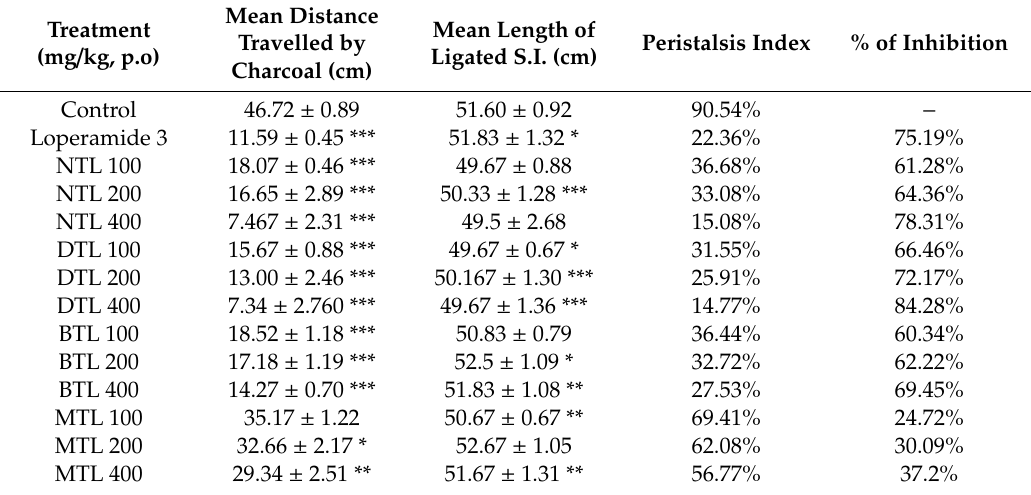
Table 4. E ff ect of methanol extract of T. leucostaphylum leaves and its derived fractions on castor oil induced intestinal transit in mice (using a charcoal meal as a marker). Treatment (mg / kg,